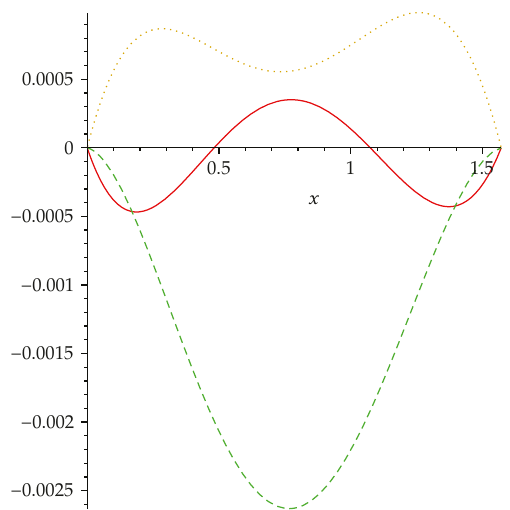
Figure 1: The residual errors between the approximating polynomial of degree 3 and sin c (cid:2) x (cid:6) with the square norm, where we denote the yellow dotted line by (cid:5) . line by (cid:5) sinc (cid:2) x (cid:6) − p 3